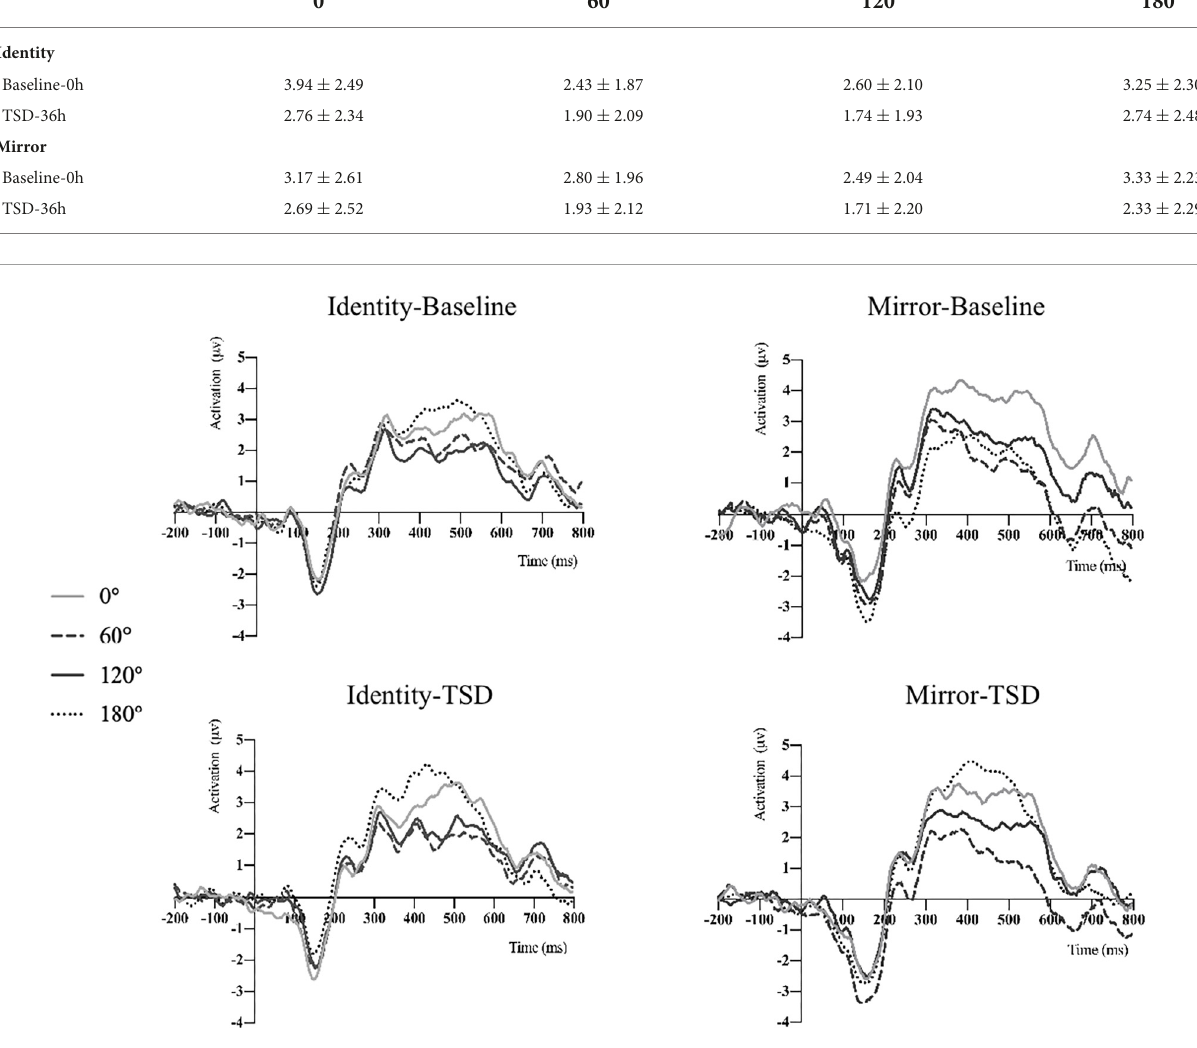
FIGURE2 P300 average amplitude of mental rotation tasks before and after TSD was detected on the Pz electrode under the two